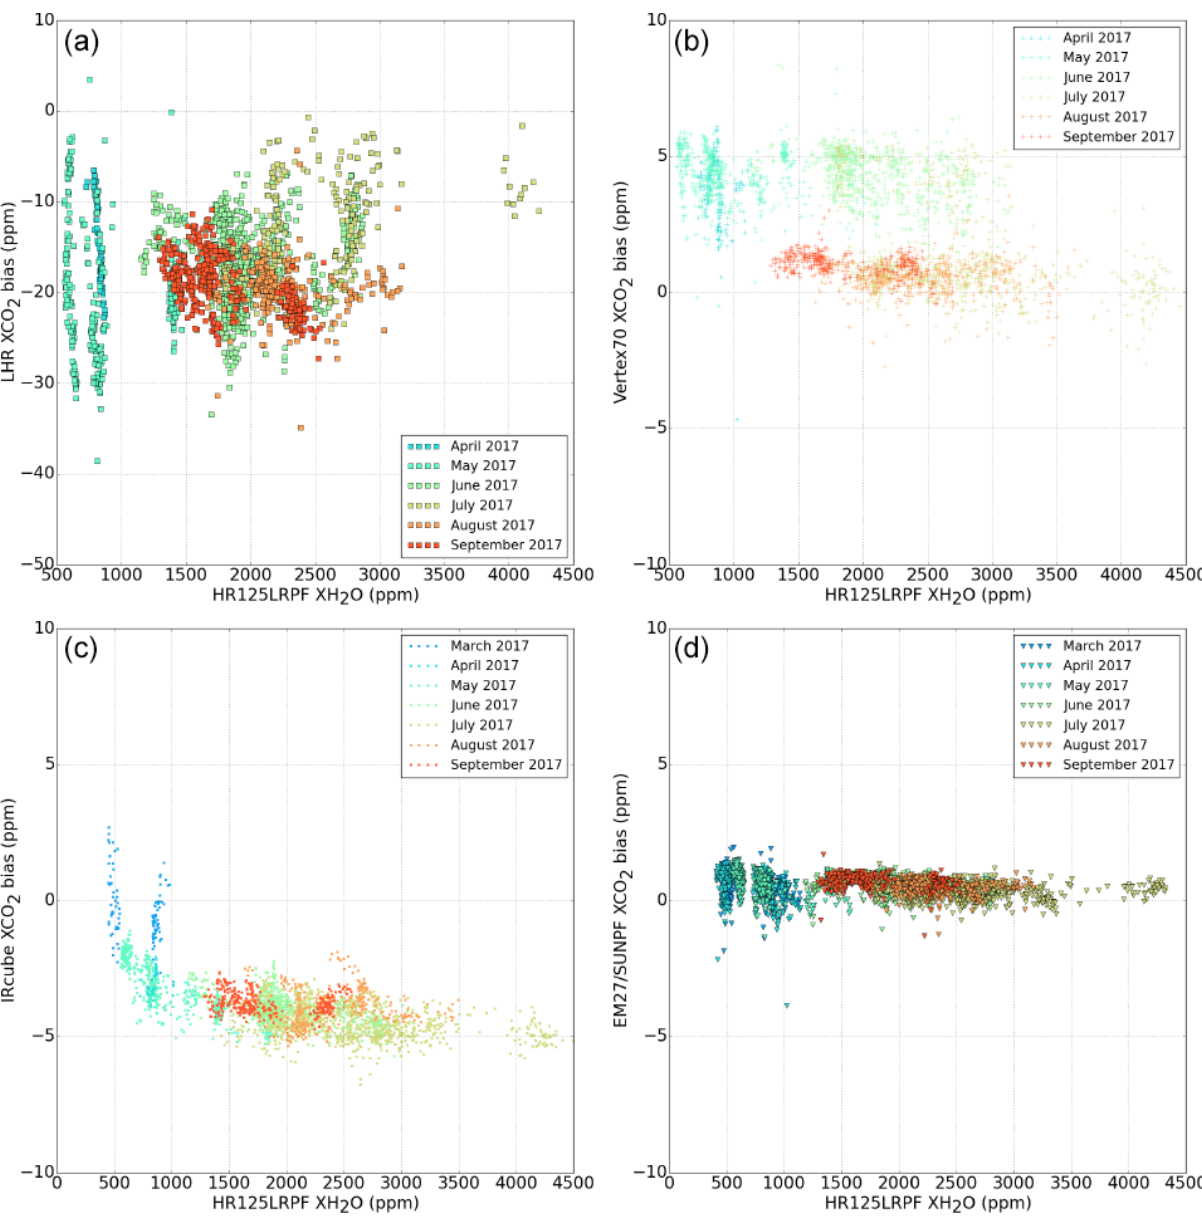
Figure F1. XCO 2 bias relative to HR125LR for each instrument plotted with respect to the total column water vapour retrieved by the reference HR125LR measurements: LHR (a) , Vertex70 (b) , IRcube (c) , EM27/SUN (d) . The colours represent the measurement performed during the different months of the